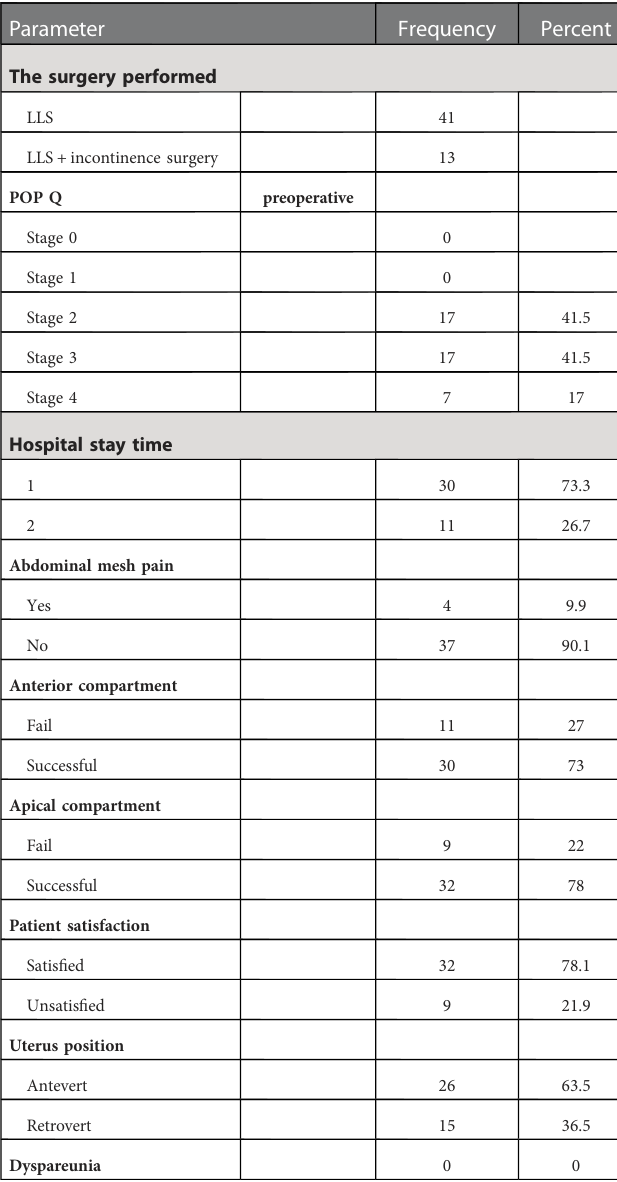
TABLE 1 Medical and sociodemographic characteristics of patients measured as categorical variables.